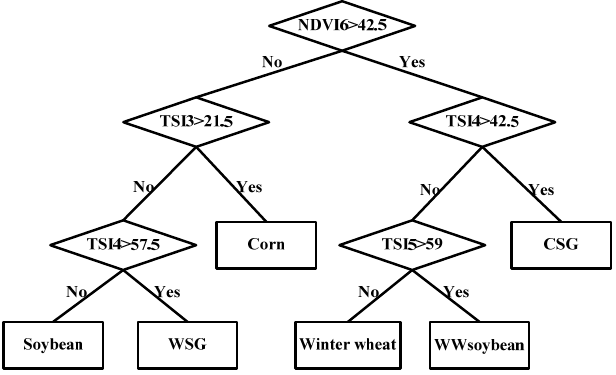
Figure 4. The DT generated using training samples.